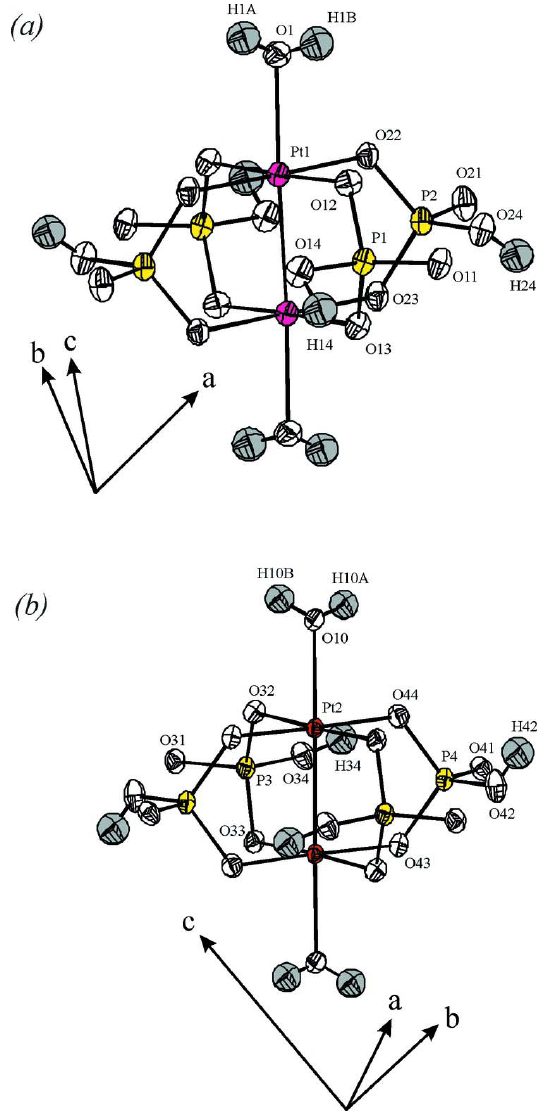
Figure 1 Pa ddle-wheel complex [(Pt III ATOMS